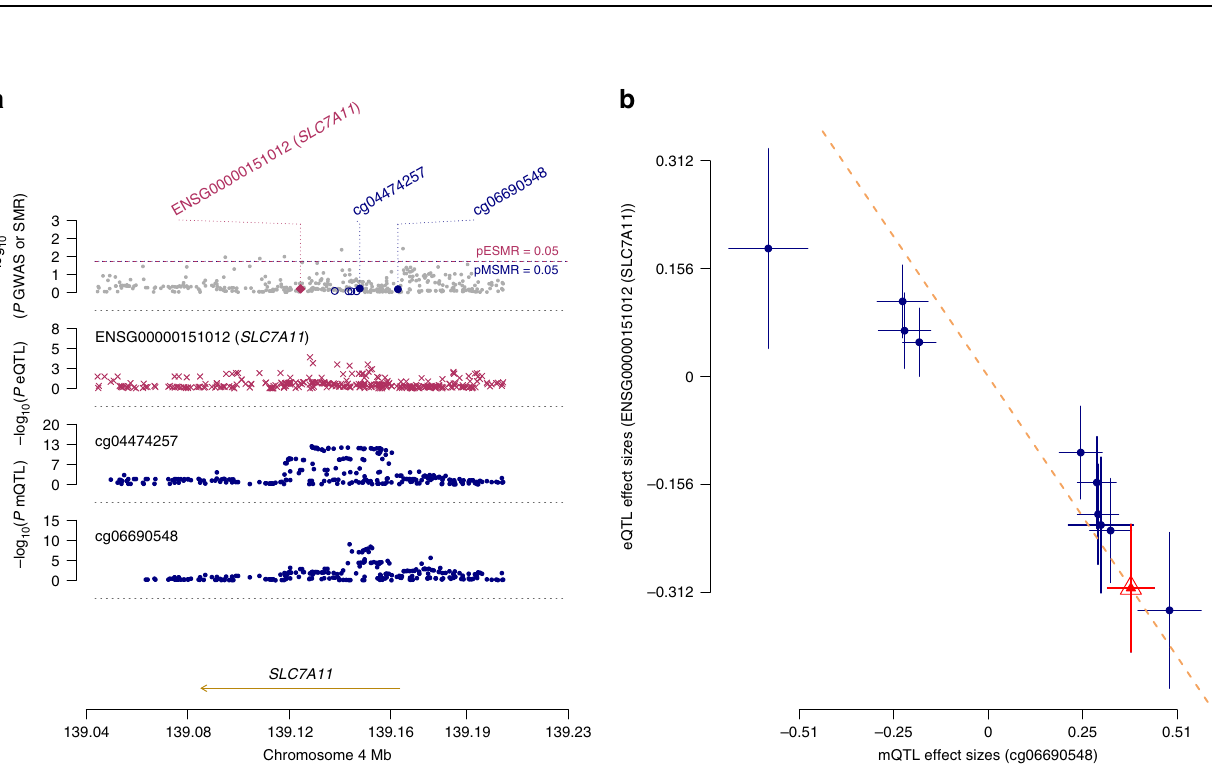
Fig. 3 Summary data-based Mendelian randomization analyses at the SLC7A11 locus. a The uppermost plot shows − log 10 ( P values) of SNPs from the PDWBS GWAS meta-analysis 63 . The red diamonds and blue circles represent − log 10 ( P values) from SMR tests for association of gene expression and DNA methylation probes with PD, respectively. Neither SLC7A11 nor cg06690548 show evidence for a genetic association with PD. The middle plot shows − log 10 ( P values) of the SNP associations for gene expression probe ENSG00000151012 (tagging SLC7A11 ) from the Brain-eMeta eQTL study 57 . The bottom plot shows − log 10 ( P values) of the SNP associations for DNA methylation probe cg06690548 from the Brain-mMeta mQTL study 57 . b Relationship between effect sizes of mQTLs for cg06690548 from the Brain-mMeta mQTL study 57 and the corresponding effect sizes for gene expression probe ENSG00000151012 from the Brain-eMeta eQTL study 57 (SMR, p = 3.59 × 10 − 03 ). The red triangle shows the top cis-mQTL, blue circles indicate cis-mQTLs. Error bars show the standard errors of the SNP